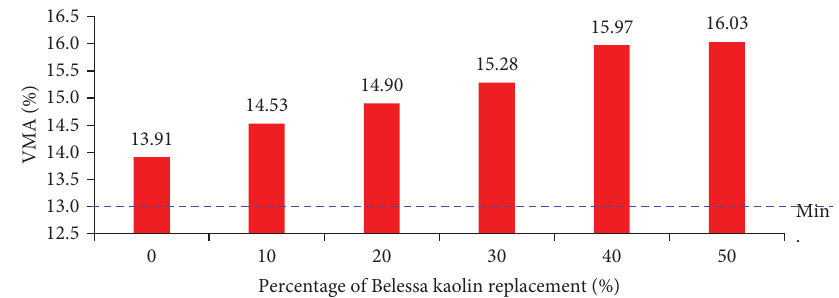
Figure 11: Relationship between VMA and replacement proportion of Belessa kaolin at